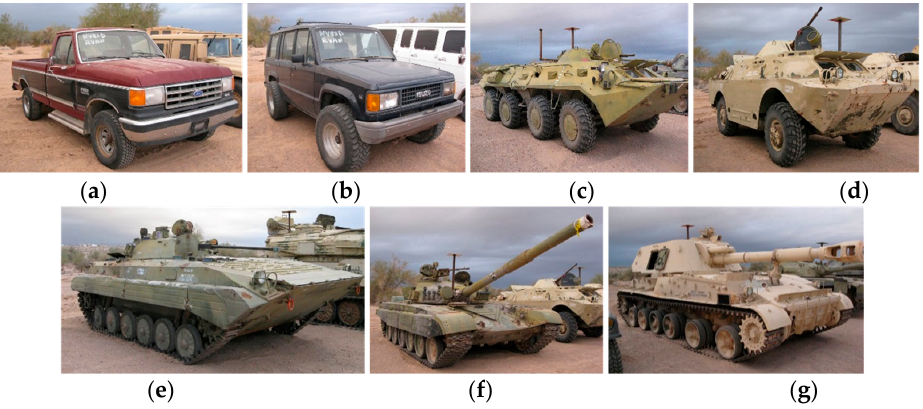
Figure 4. Seven targets in SENSIAC: ( a ) Truck; ( b ) SUV; ( c ) BTR70; ( d ) BRDM2; ( e ) BMP2; ( f ) T72; and ( g ) ZSU23-4.